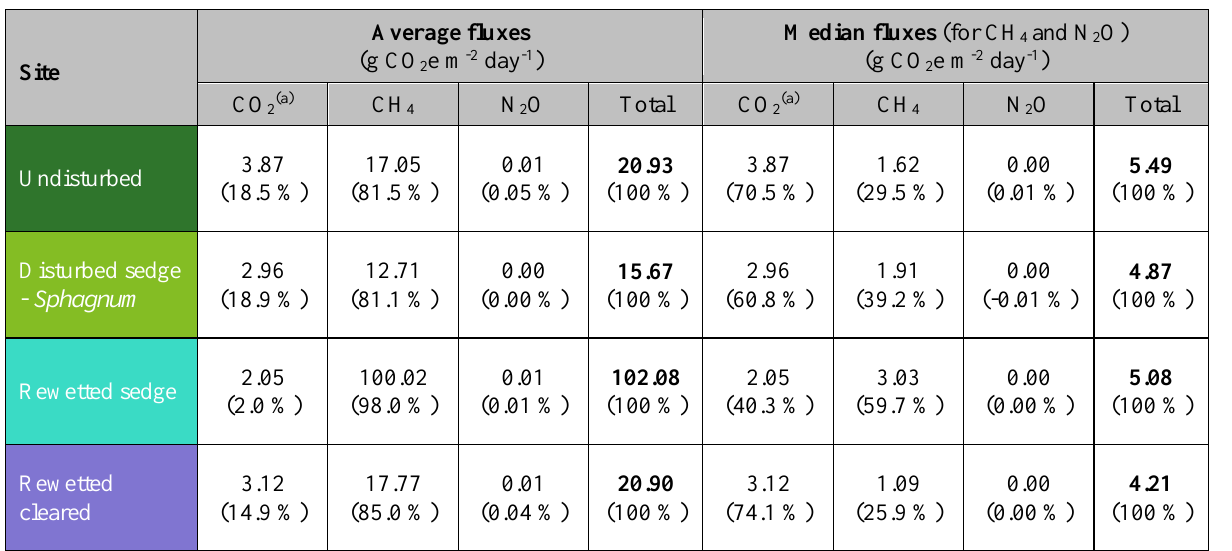
Table 3. Calculated total 100-yr global warming potential (GWP; g CO 2 e m -2 day -1 ) by site and greenhouse gases (GHG) based on measured average and median summertime fluxes from all collars at each of the four chamber